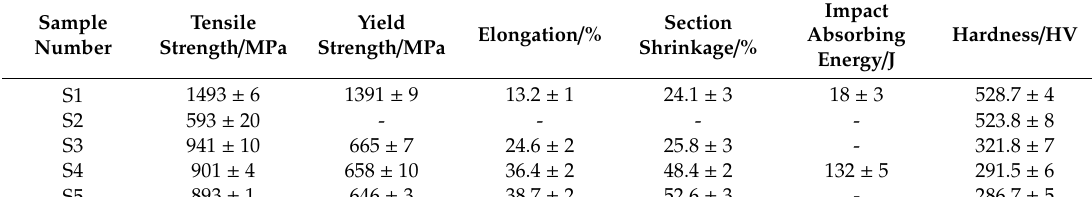
Table 4. The mechanical properties of specimens processed under different conditions.